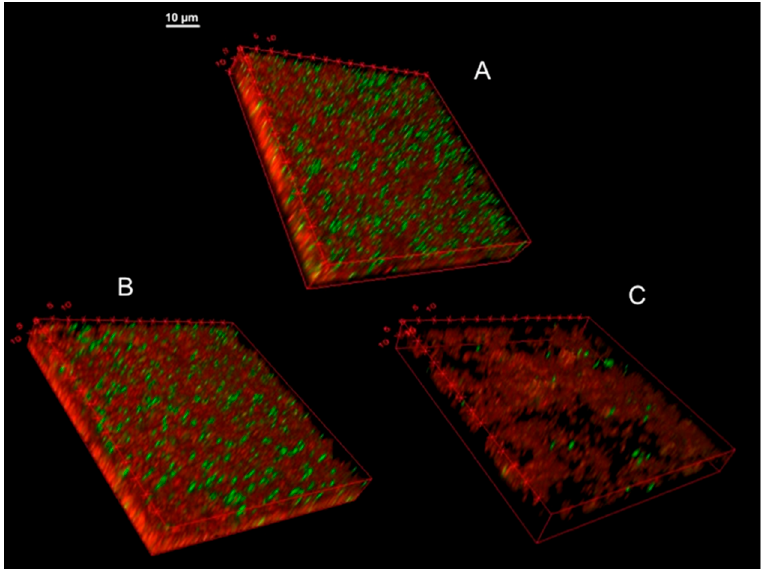
Figure 7. 3D images of KpTs101 BF treated with AMPs. The biofilm formed after 24 h growth by KpTs101 on glass was incubated for further a 24 h in saline solution alone ( A ); or with addition of 64 µM Bac7(1–35) ( B ); or BMAP-27 ( C ), gently washed and stained with the live/dead kit: live bacteria were stained green and dead bacteria were stained red. Z-stacks were acquired with a 60×/1.4 oil objective at 0.33 µm intervals.